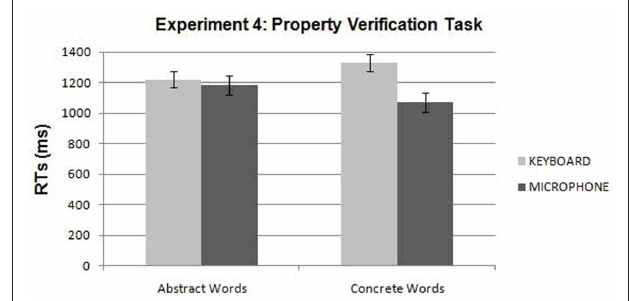
Figure 5 | experiment 4: interaction between Word (Abstract, Concrete) and response device (Keyboard,